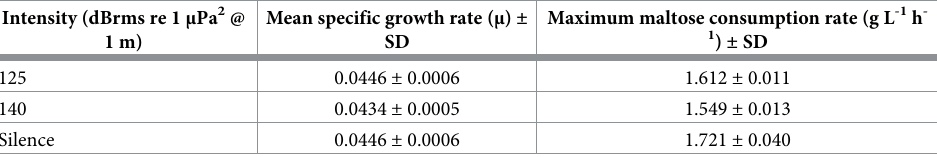
Table 4. Effects of sound intensity on specific growth rates of S . cerevisiae